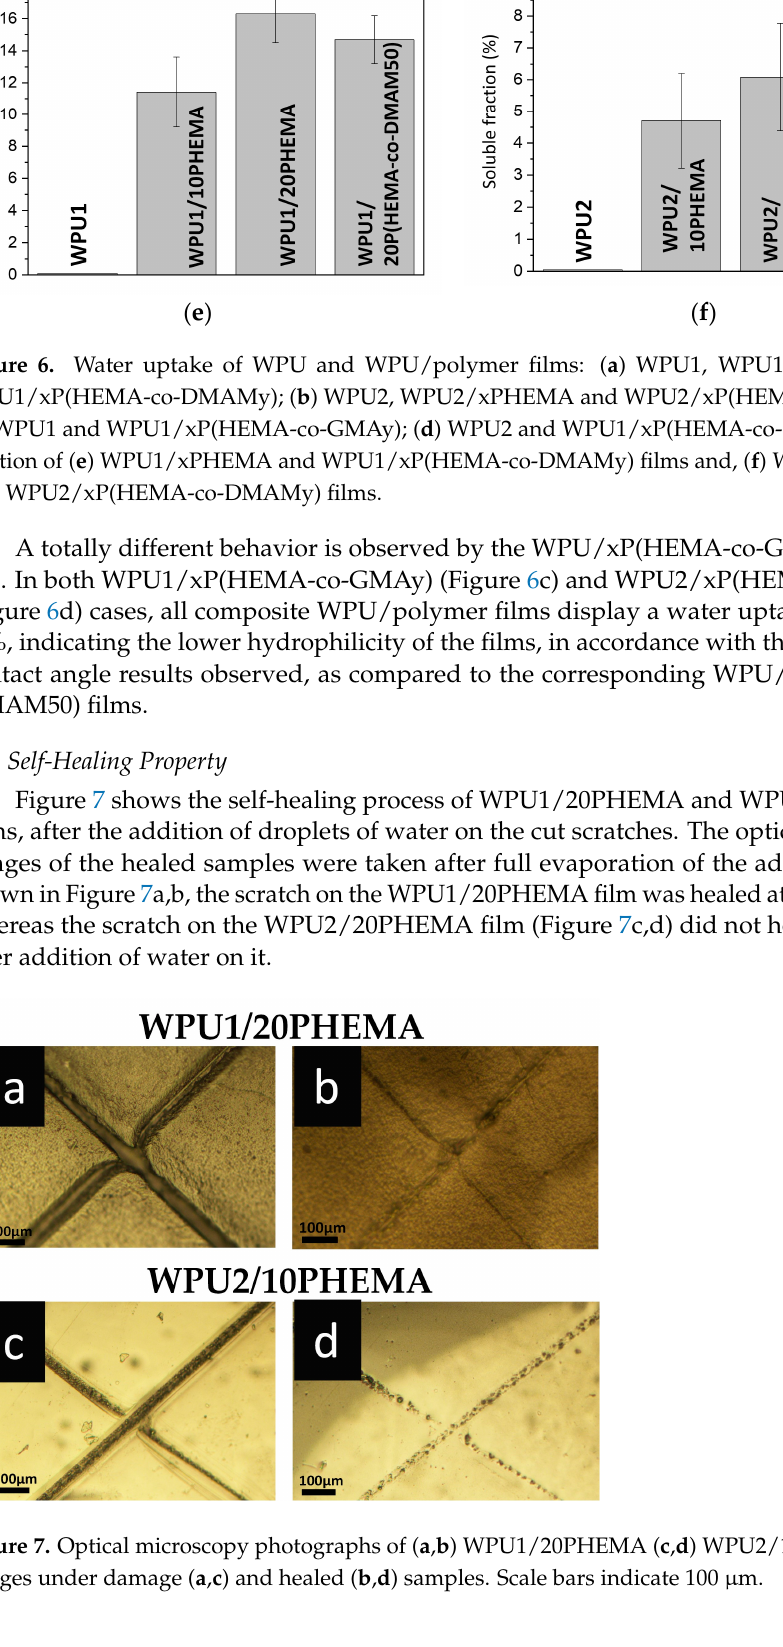
Figure 7. Optical microscopy photographs of ( a,b ) WPU1/20PHEMA ( c,d ) WPU2/10PHEMA films: images under damage ( a,c ) and healed ( b,d ) samples. Scale bars indicate 100 μ m. Figure 8e,f, and WPU2/10P(HEMA-co-